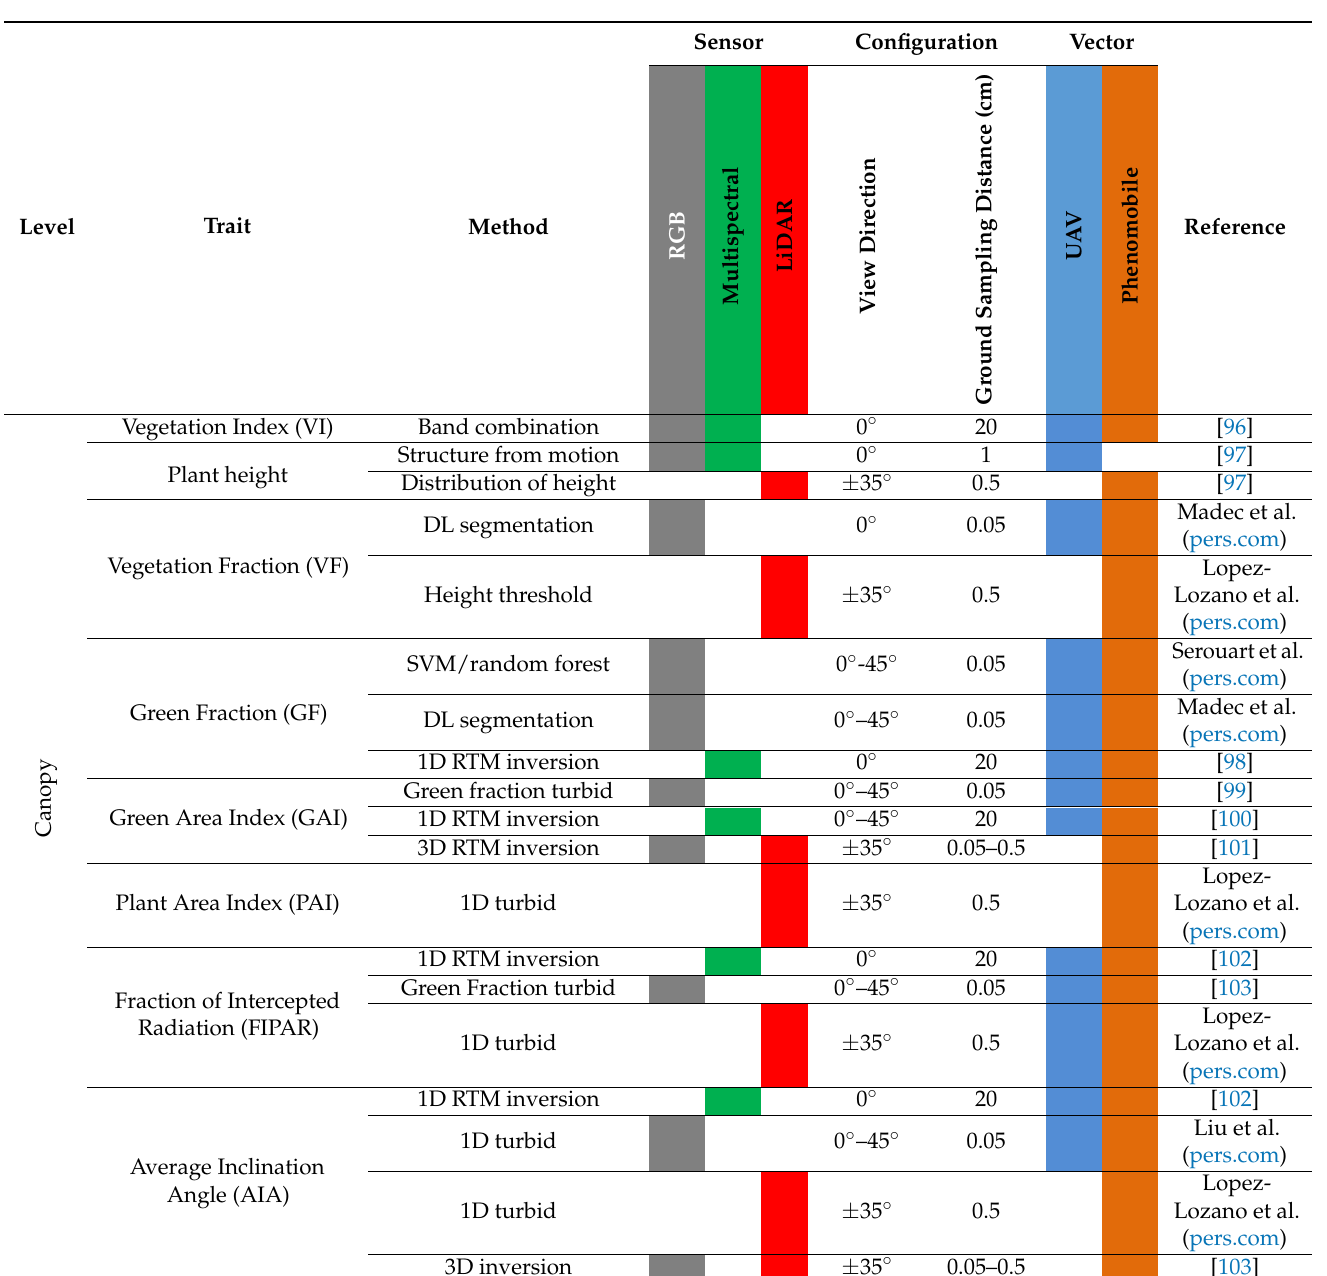
Table 2. Traits that can be estimated from high-throughput systems developed within BREEDWHEAT and Phenome-Emphasis projects that can be applied to wheat crops. DL: deep learning, RTM: radiative transfer model, SVM: support vector machine, VI: vegetation index. Colored cell indicate that the corresponding sensor or vector was used to estimate the